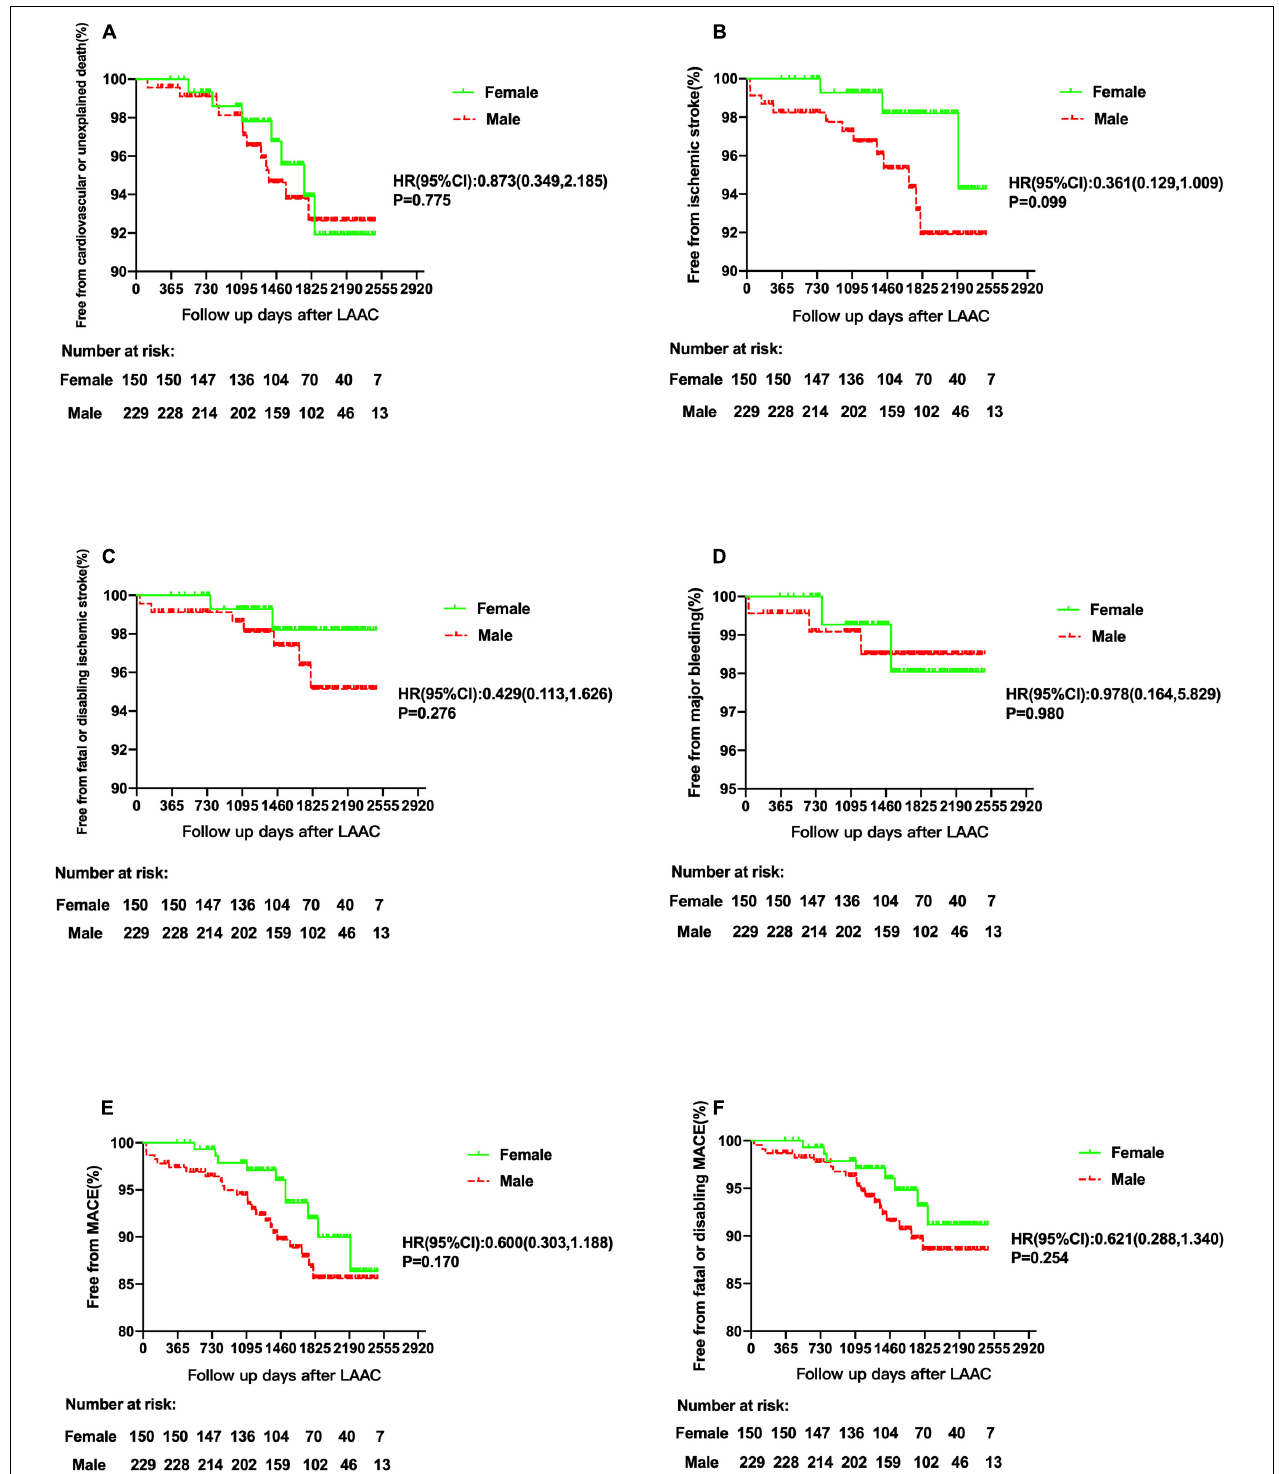
FIGURE 3 | Rates of free from cardiovascular or unexplained death, ischemic stroke, fatal or disabling ischemic stroke, major bleeding, MACE, and fatal or disabling MACE between female and male patients. Kaplan–Meier curves of cardiovascular or unexplained death (A) , ischemic stroke (B) , fatal or disabling ischemic stroke (C) , major bleeding (D) , MACE (E) , and fatal or disabling MACE (F) according to female and male patients. MACE, major adverse cardiovascular events, including cardiovascular or unexplained death, ischemic stroke or major bleeding; LAAC, left atrial appendage closure; HR, hazard ratio; CI, confidence interval.